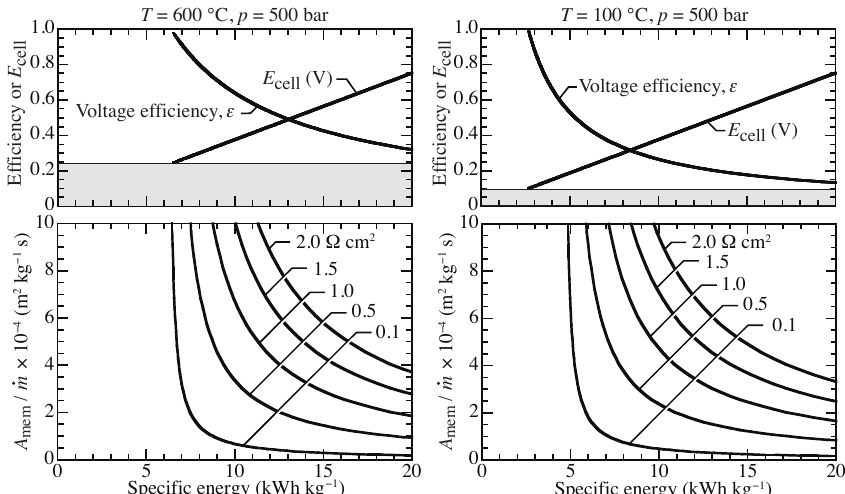
Figure 9. Isothermal electrochemical compression from 1 to 500 bar across a proton conducting membrane at 600 and 100 ◦ C for area specific resistance (ASR) between 0.1 Ω cm 2 and 2 Ω cm 2